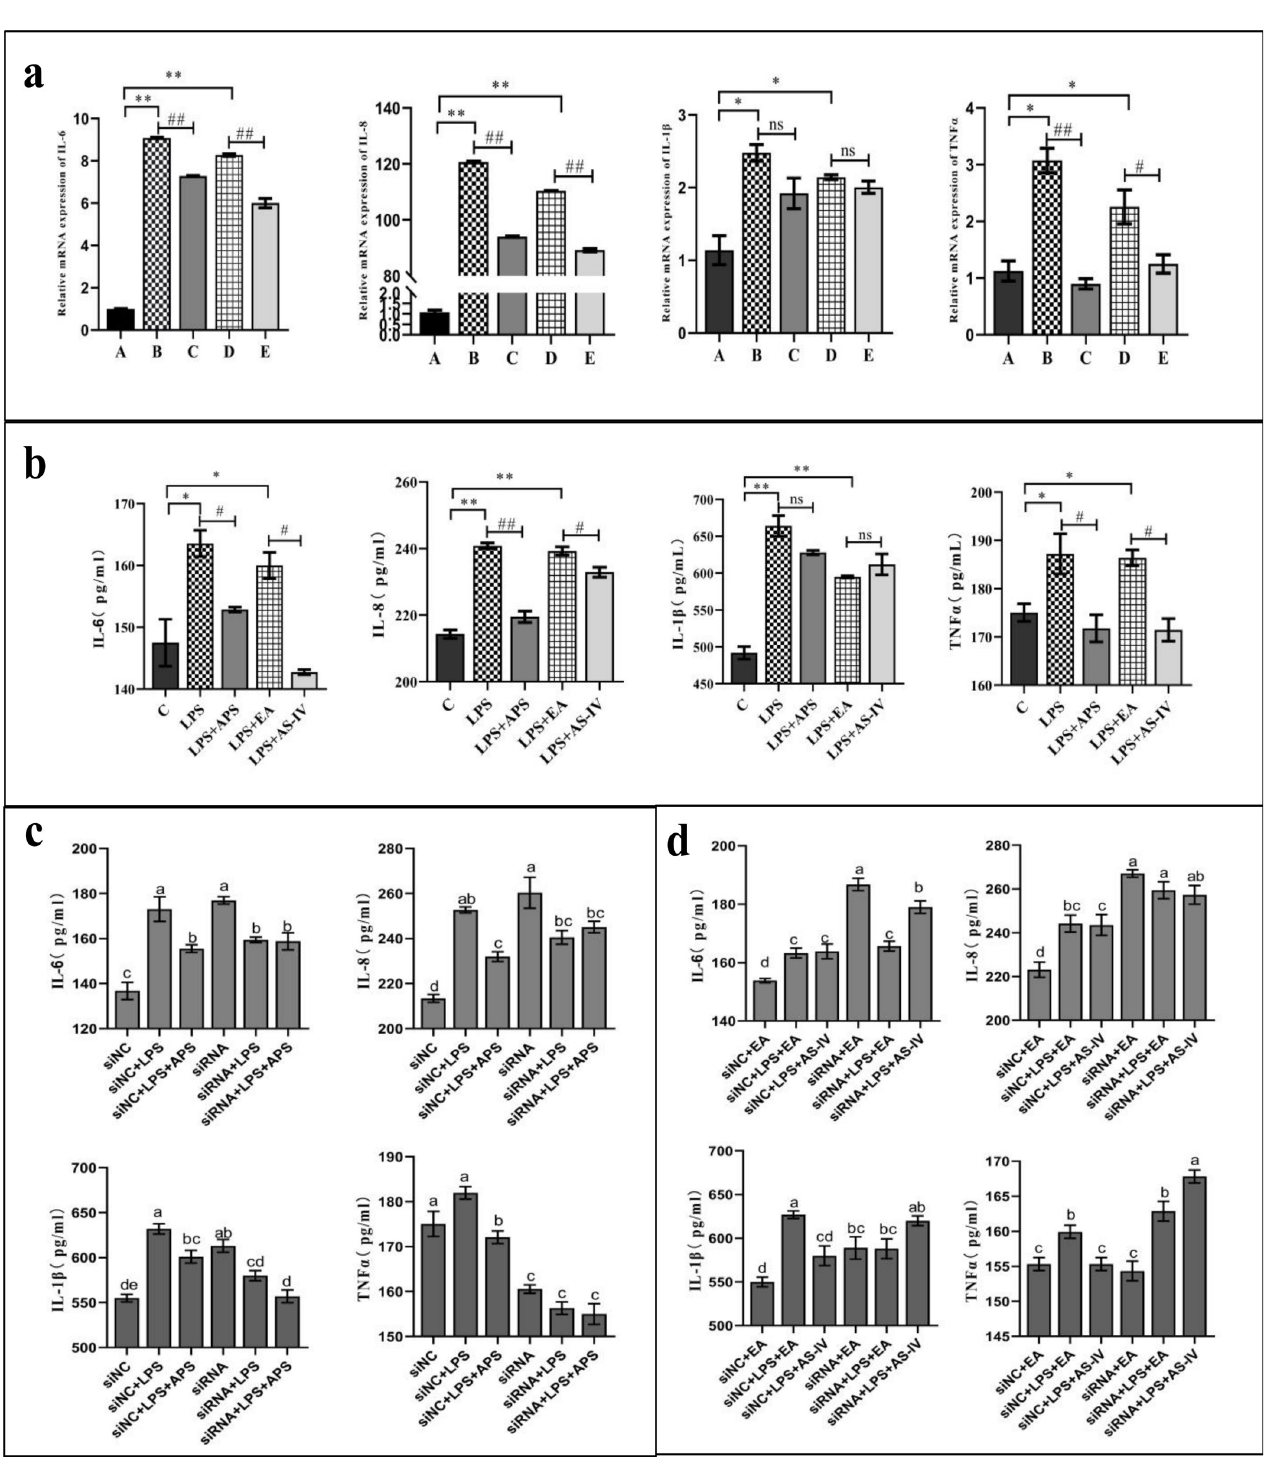
Fig 5. APS and AS-IV inhibit the expression of inflammatory factors in BMECs under an inflammatory state. (a, b) APS and AS-IV suppress the expression of inflammatory factor genes and proteins in LPS-stimulated BMECs. C = Control cells without any processing; LPS = cells treated with LPS (0.5 μ g/ mL) alone; LPS + APS = LPS (0.5 μ g/mL) + APS (1 mg/mL); LPS + EA = LPS (0.5 μ g/mL) + ethanol concentration 1% (vol/vol); LPS + AS-IV = LPS (0.5 μ g/ mL) + AS-IV (100 μ g/mL). (c, d) APS and AS-IV fail to inhibit inflammatory factors in BMECs under an inflammatory state after silencing β -catenin. Each experimental group expresses the same meaning as in Fig 4C and 4D. Data are expressed as the mean ± SD of 3 independent experiments. � , # represents 0.01 < P < 0.05, �� , ## represents P < 0.01, ns represents P > 0.05, and letter differences in the graphs indicate significant P < 0.05 differences between groups.